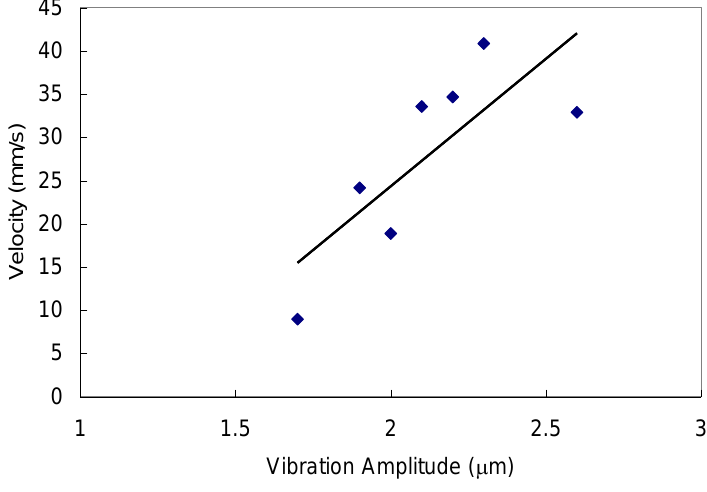
Figure 11. Velocity versus vibration amplitude for the 1,090 Hz mode.